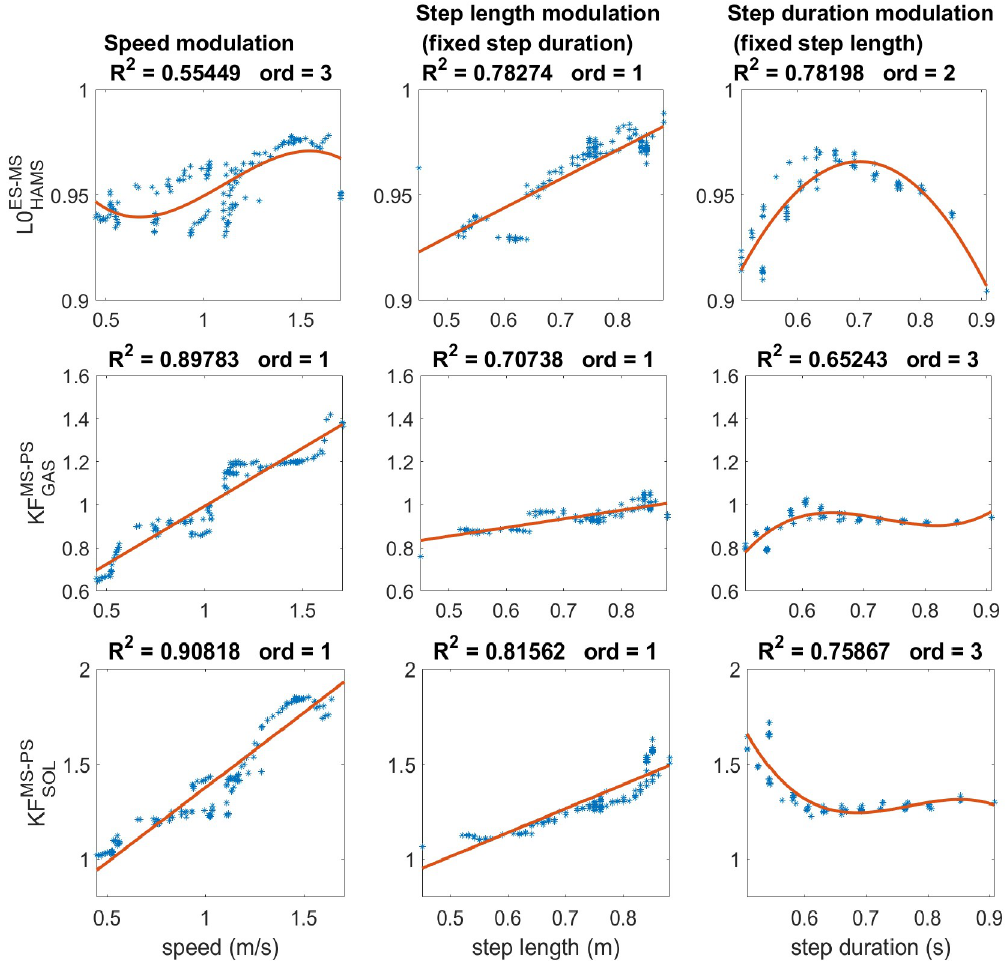
Fig 2. Regression analysis of step length modulators. The solutions obtained by the three sets of optimizations are represented by the blue dots, whereas the red curve represents the regression. The plot on the left shows the data distribution and regression for the speed modulation, while the plots on the center and the right show the step length and step duration modulation, respectively. The reflexes presented facilitate speed and step length increasing with minimal effect on the step period. The offset length of the hamstrings’ stretch reflex presents an influence on step duration modulation, but the global increasing tendency of speed reflects the behavior found in the modulation of step